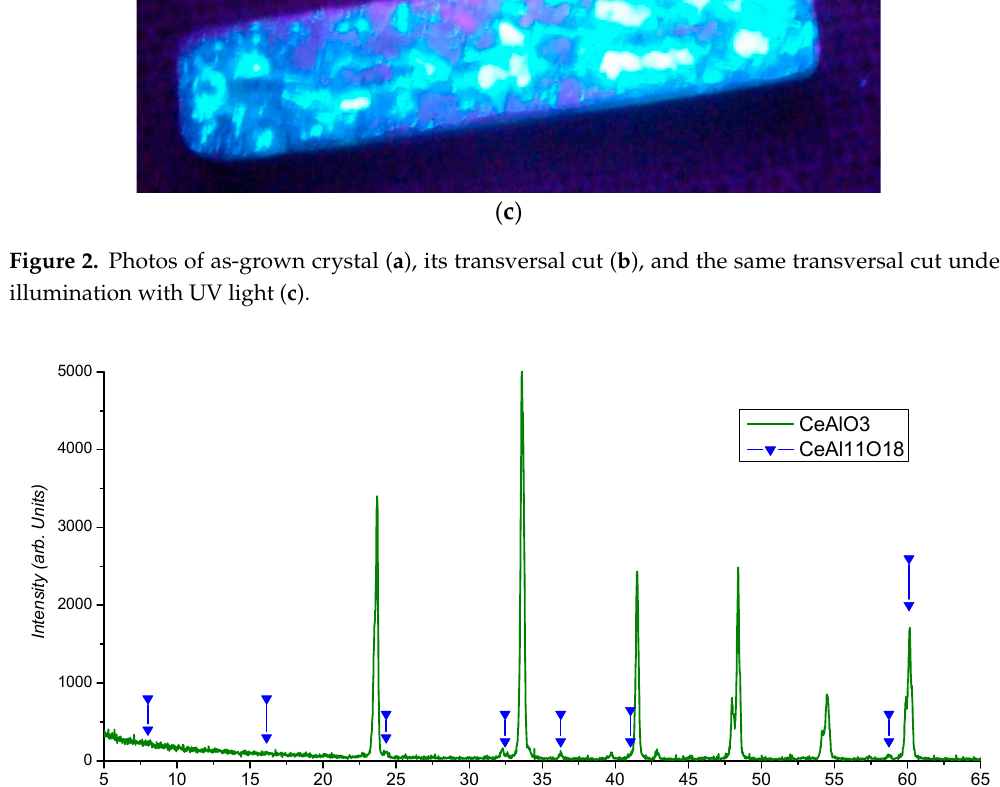
Figure 3. XRD of the transverse cut of polycrystalline sample grown by the edge-defined film-fed (EFG) technique.